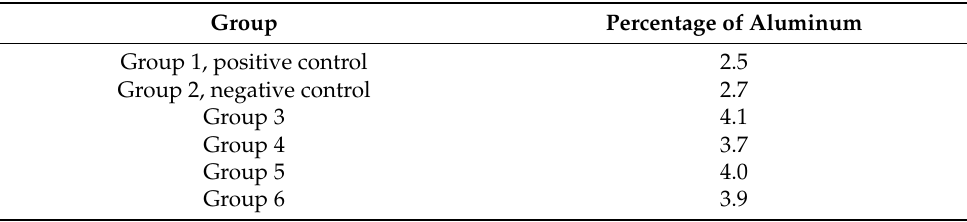
Figure 4. Scanning electron microscopy (SEM) images (5000 × magnification) of the composite surfaces of all groups. G1: positive control group; G2: negative control group; G3–G6: composite substrate surfaces sandblasted from working distances of 1 mm (G3), 5 mm (G4), 10 mm (G5), and 15 mm (G6). Table 2. Energy dispersive X-ray spectroscopy (EDX) weight percentages (wt%) of aluminum components on the composite substrate surfaces per